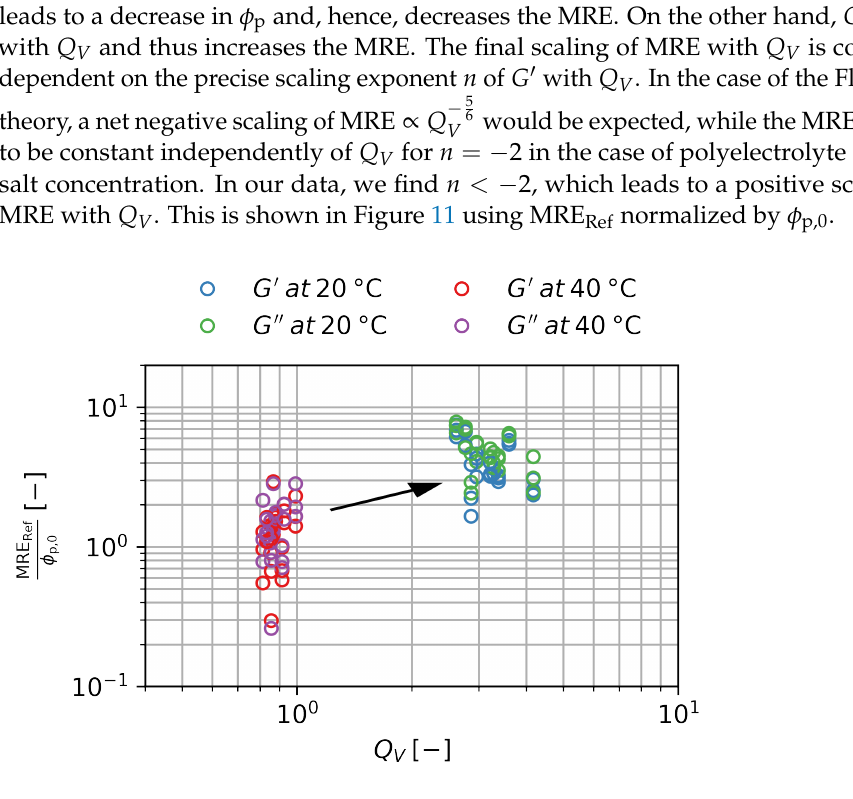
Figure 11. Magnetorheological effect at B = 500mT normalized to the initial particle volume fraction over degree of swelling for the storage and loss modulus. Three samples per w s are shown. Error bars are smaller than the